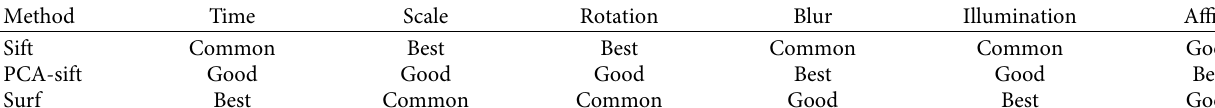
Table 1: Performance of three